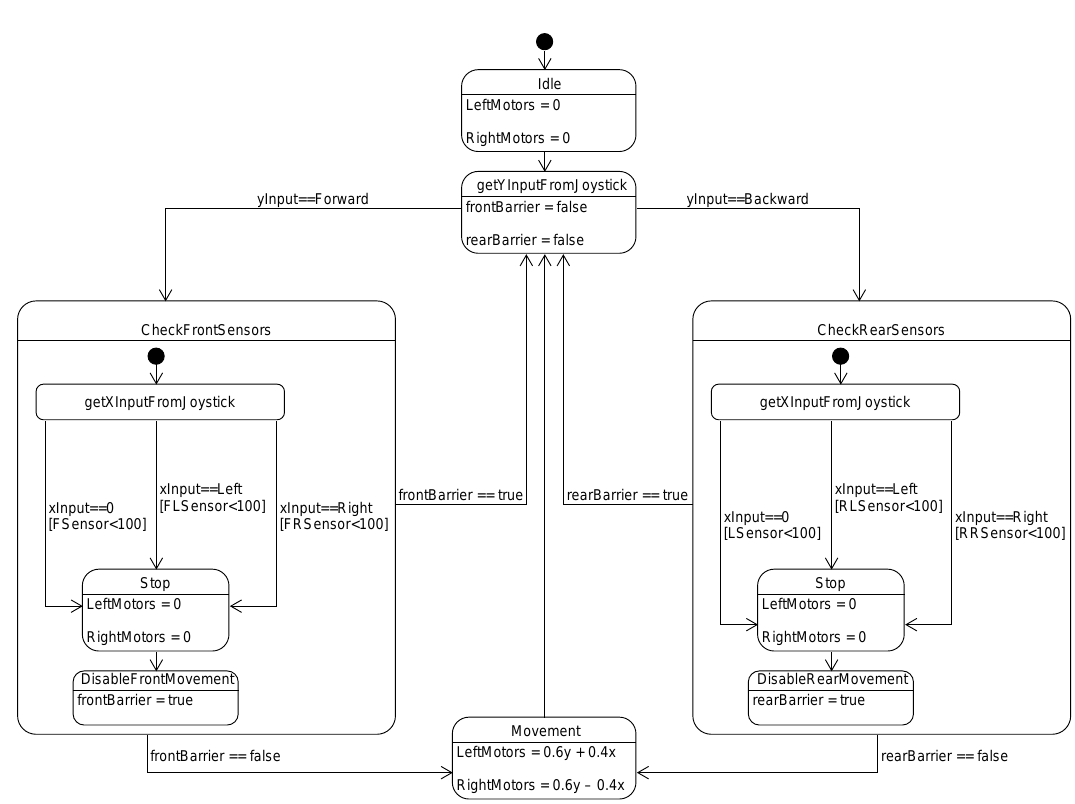
Figure 8. Remote control with collision avoidance UML